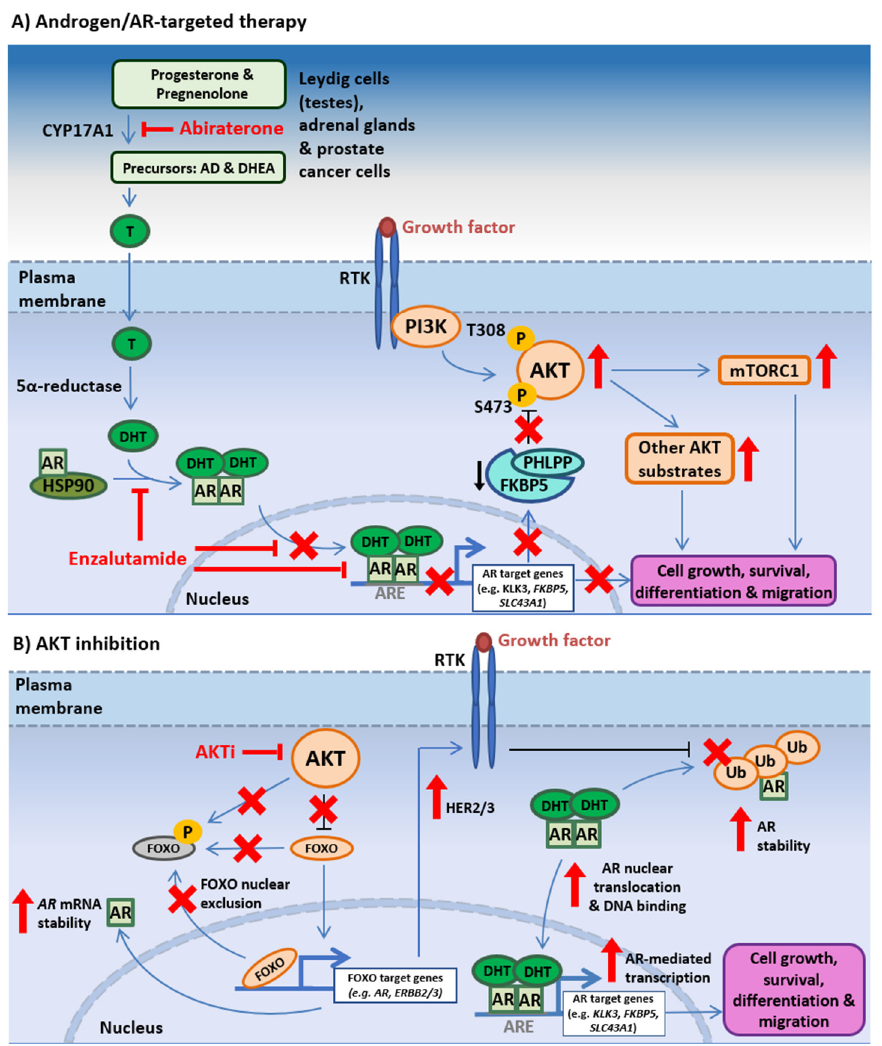
Figure 3. PI3K-AKT-mTOR and AR signaling crosstalk facilitates resistance to androgen / AR and AKT-directed monotherapy. Schematics depict reported model mechanisms for therapeutic resistance to ( A ) androgen / AR-directed therapy, which leads to increased AKT activation, and ( B ) AKT inhibition. AD, androstenedione; CYP17A1, cytochrome P450 17A1; DHEA, dehydroepiandrosterone; Ub, ubiquitination event.